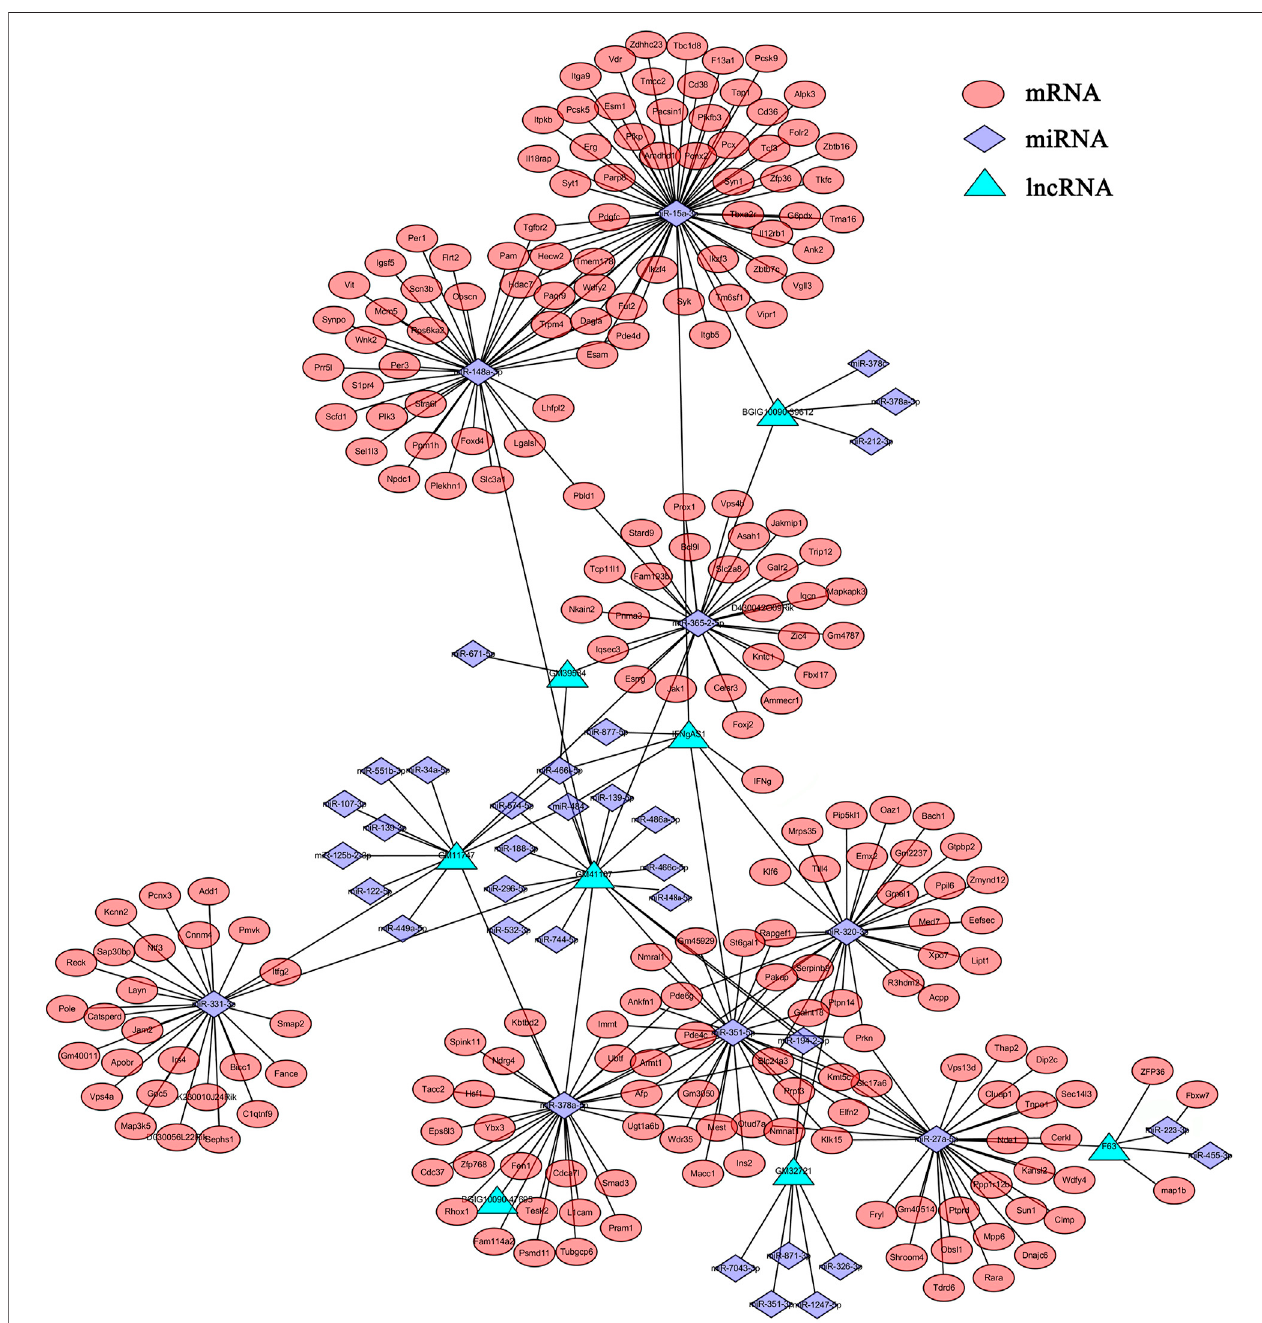
FIGURE 3 | The lncRNA-mRNA-miRNA network. The relationships of lncRNAs-miRNAs-mRNAs were constructed based the results of predicted targets using Cytoscape software (v3.6.1). Different colors were used to show different genes, with green for DElncRNAs, purple for DEmiRNAs and red for DEmRNAs.